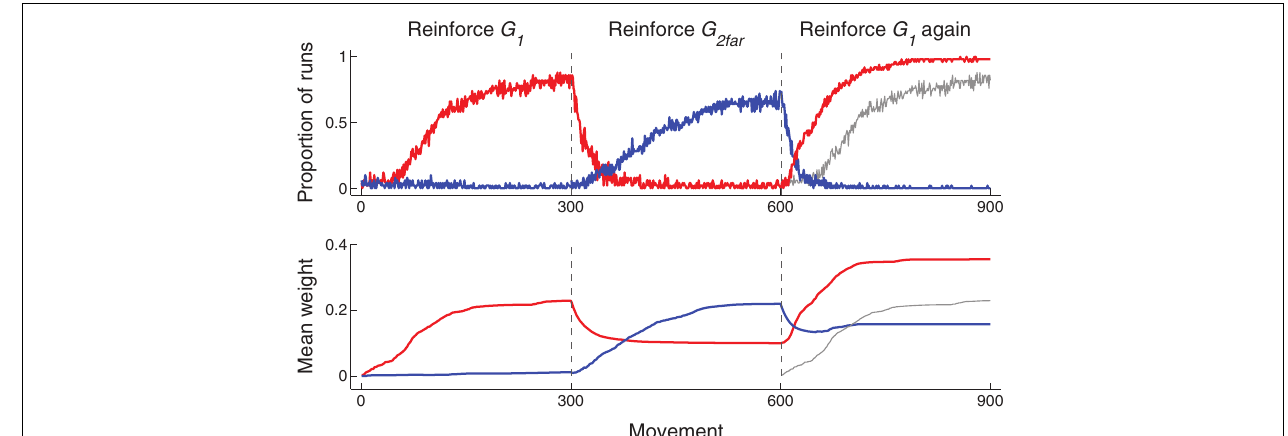
particular run. The D1 neuron that corresponded to most movements that hit each target was determined by finding the maximum weight from Context to D1 neurons at the end of each 300 movement segment. Because several movements can hit each target, only runs in which the same D1 neuron was selected at movement 300 and movement 900 (i.e., for movements that hit G 1 ) were included (16 out of 50 runs were excluded). That for weights from Context neuron to D2 neurons followed a similar pattern and are not plotted. Similar to the graphs in the top row, mean weight during movements 1–300 are plotted again at movements 601–900 in gray for comparison purposes.